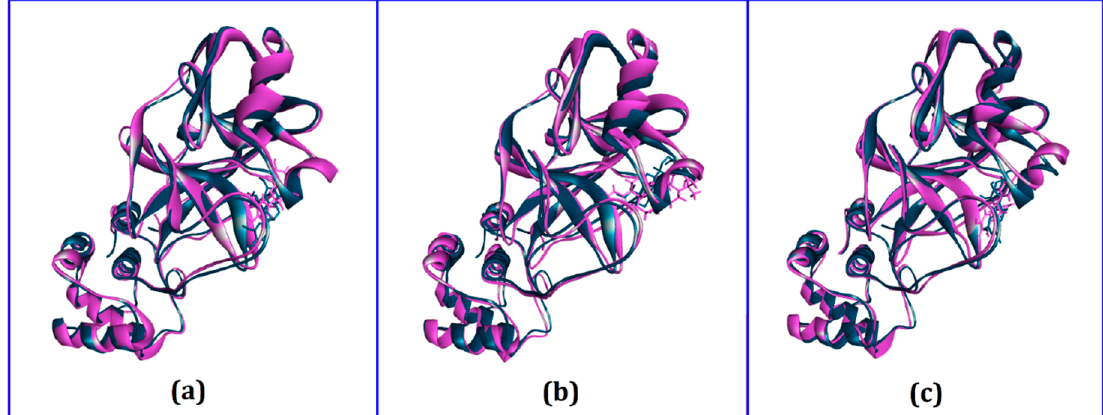
Figure 4. Superimpositions of the drug–protein complex before and after molecular dynamics. Purple color indicates the baseline structure and dark blue indicates the structure after molecular dynamics. ( a ) Epicatechin-3-O-gallate, ( b ) Psi- taraxasterol, and ( c ) Catechin gallate.